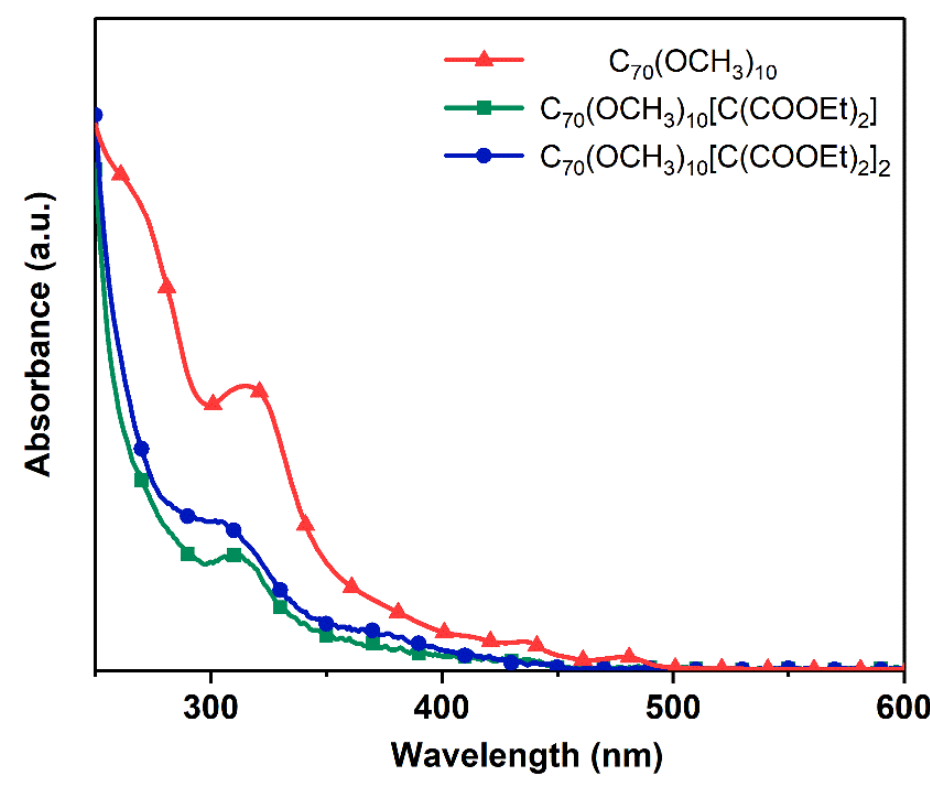
Figure 2. UV-vis absorption spectra of C 70 (OCH 3 ) 10 , C 70 (OCH 3 ) 10 [C(COOEt) 2 ], and C 70 (OCH 3 ) 10 [C(COOEt) 2 ] 2 in a 1.0 × 10 − 5 mol/L chloroform solution at room temperature. To obtain information about the photophysical properties of the C 70 (OCH 3 ) 10 , C 70 (OCH 3 ) 10 [C(COOEt) 2 ], and C 70 (OCH 3 ) 10 [C(COOEt) 2 ] 2 , we measured the steady-state fluorescence spectra of these C 70 derivatives. As shown in Figure 3, the emission peak of the C 70 (OCH 3 ) 10 was 498 nm, with a shoulder peak at 521 nm. The major emission peak at 498 nm was ascribed to the S 1 → S 0 transition, and the shoulder peak was ascribed to the transition involving the vibronic interactions [4,5]. The fluorescence spectra of the C 70 (OCH 3 ) 10 [C(COOEt) 2 ] and C 70 (OCH 3 ) 10 [C(COOEt) 2 ] 2 were rather similar. The major peaks appeared at 451 and 454 nm for the C 70 (OCH 3 ) 10 [C(COOEt) 2 ] and the C 70 (OCH 3 ) 10 [C(COOEt) 2 ] 2 , respectively, while the shoulder peaks were shown at 480, and 481 nm. Obviously, the fluorescence emission peaks of the C 70 (OCH 3 ) 10 [C(COOEt) 2 ] and C 70 (OCH 3 ) 10 [C(COOEt) 2 ] 2 were blue-shifted compared to those of the C 70 (OCH 3 ) 10 , indi- cating that the Bingel–Hirsch reaction can effectively reduce the π -conjugated system of the C 70 cage [21]. The fluorescence quantum yields of these fullerene derivatives were obtained with integrating spheres. The fluorescence quantum yields of the C 70 (OCH 3 ) 10 [C(COOEt) 2 ] and C 70 (OCH 3 ) 10 [C(COOEt) 2 ] 2 were 1.94, and 2.30%, respectively, which were about ten times higher than that of the C 70 (OCH 3 ) 10 (0.25%). However, the fluorescence quantum yields of both the C 70 (OCH 3 ) 10 [C(COOEt) 2 ] and the C 70 (OCH 3 ) 10 [C(COOEt) 2 ] 2 were not particularly high, which made them difficult to use as fluorescent labels.